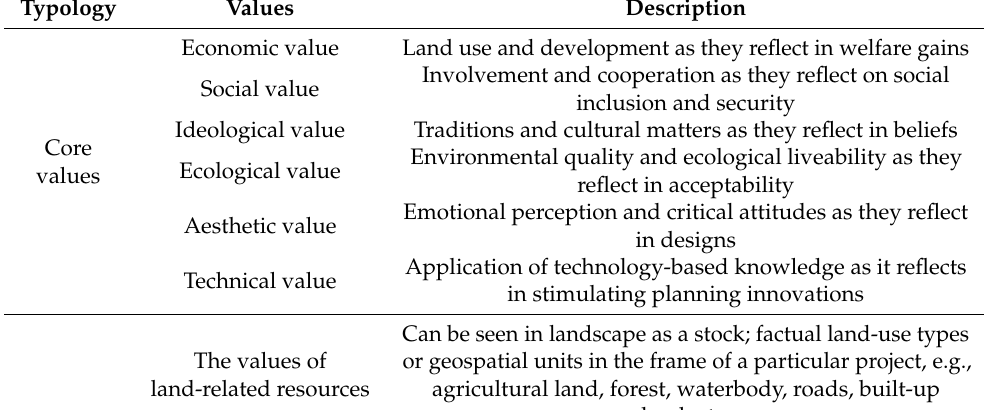
Table 1. Values and their